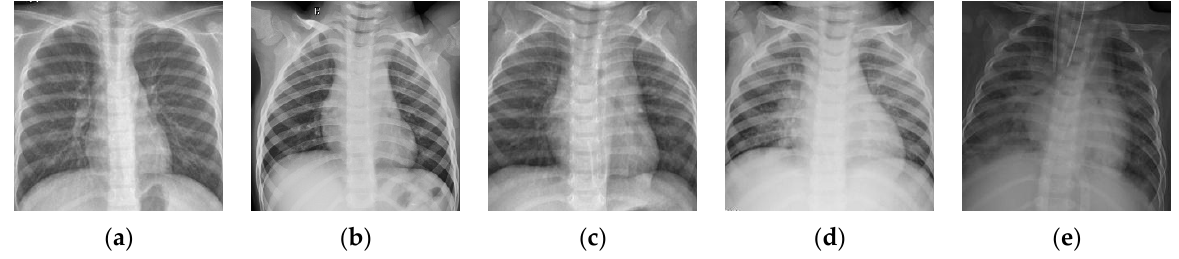
Figure 10. Examples of the dataset Chest-2. ( a – c ) Normal; ( d , e ) pneumonia. Table 5. The construction of the Chest-2 dataset.